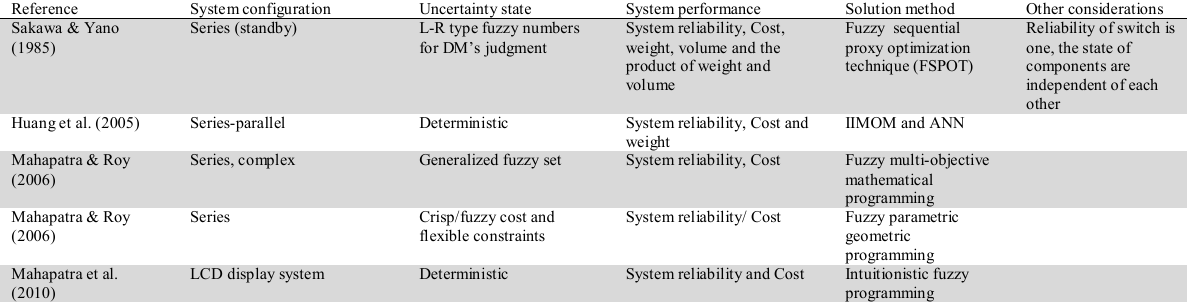
Reliability allocation (Multi Objective